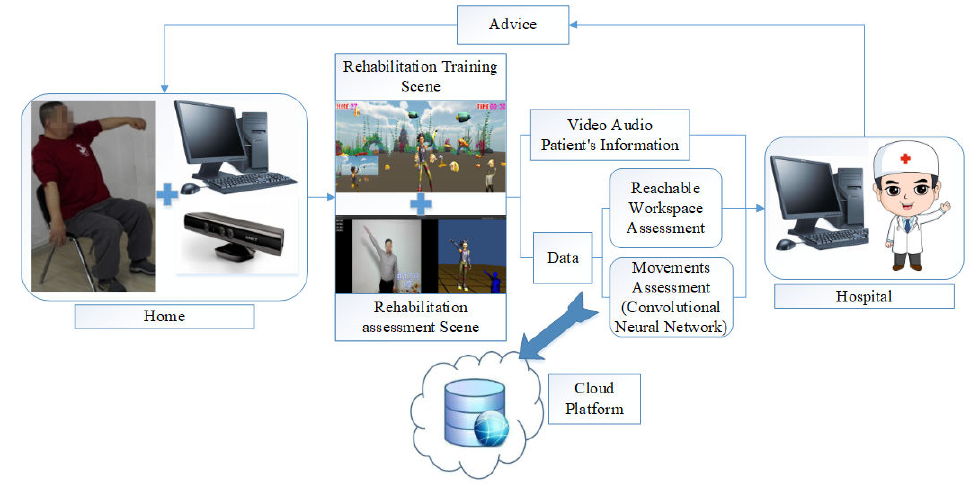
Figure 2. Diagram of cloud motion-based rehabilitation system for upper